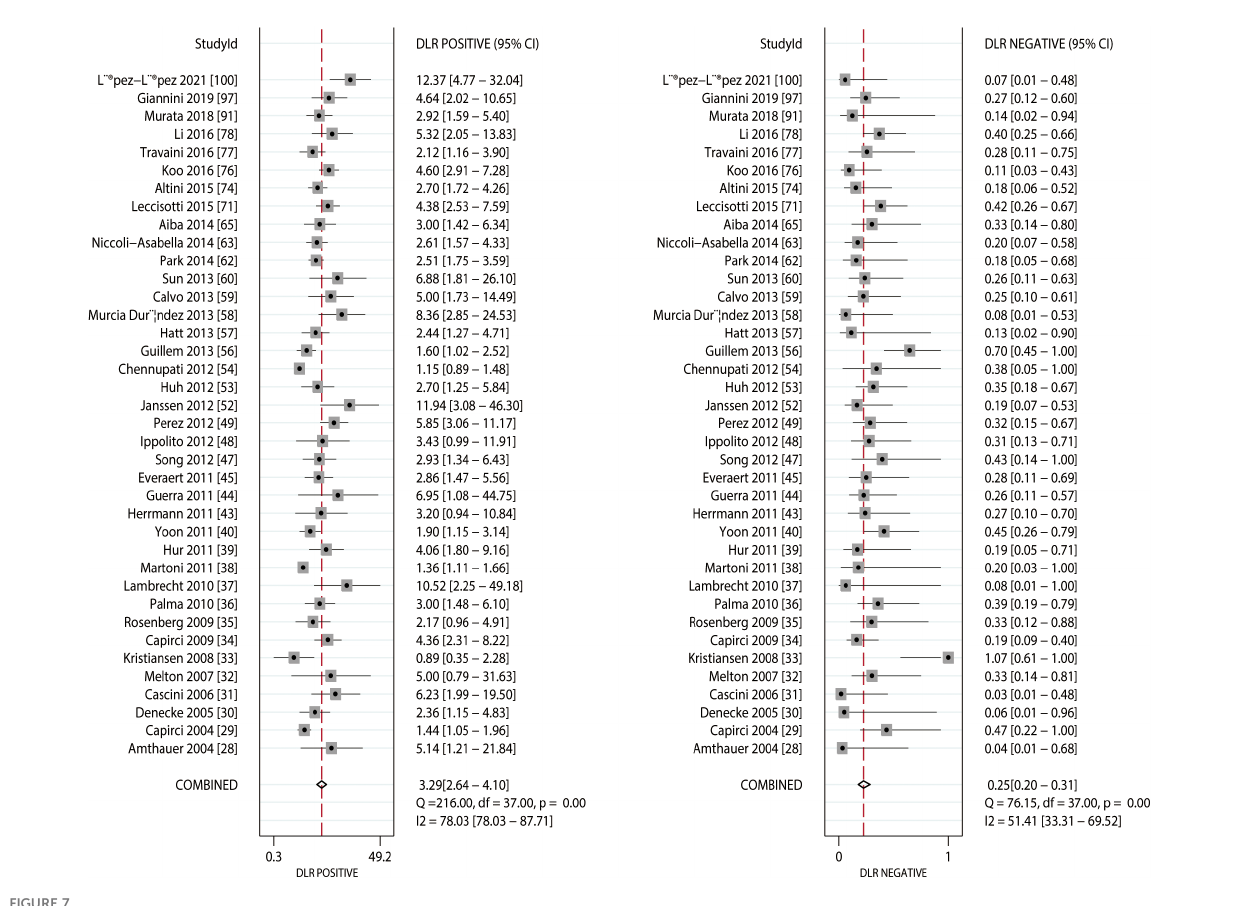
FIGURE 7 Pooled PLR and NLR of FDG-PET and FDG-PET/CT.